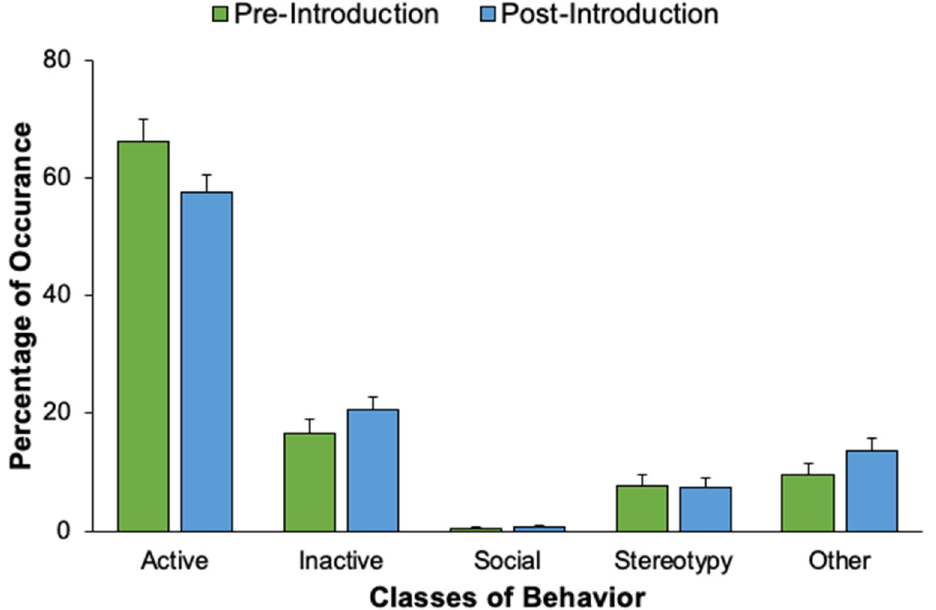
Figure 6. The percentage of occurrence (with standard error of the mean bars) that Hogan engaged in each of the five behavior classes, comparing pre-introduction and post-introduction activity lev ‐ els.